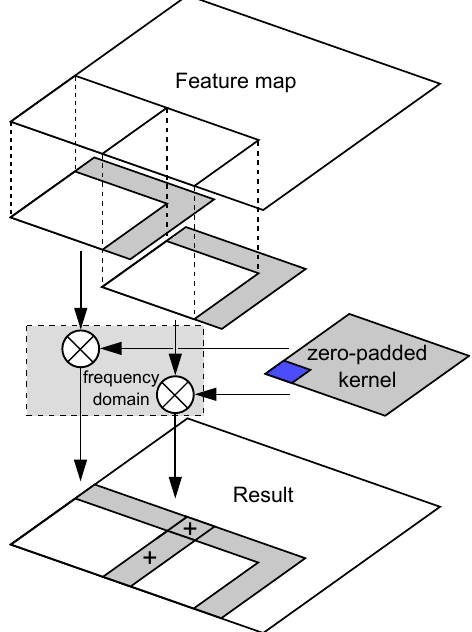
Figure 3: Overview of the overlap-add process for a single